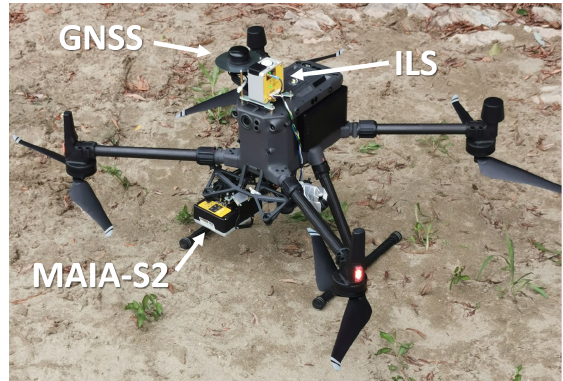
Figure 2. MAIA-S2 multispectral camera, GNSS external antenna and ILS sensor mounted on DJI Matrice 300.